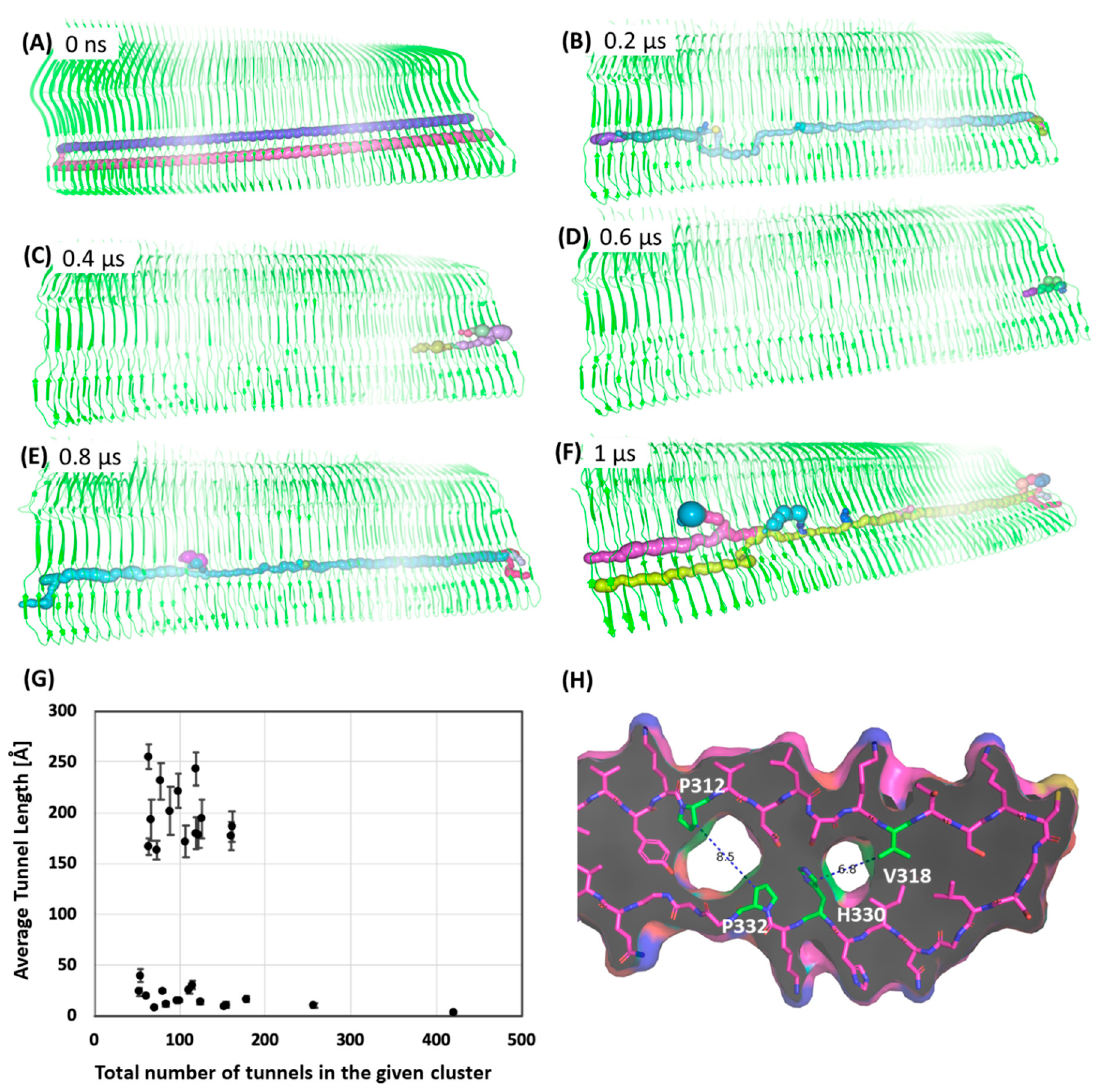
Figure 7. Tunnels predicted by the CAVER program in ( A ) cryo-EM structure and ( B – F ) structure taken from MD simulation. The snapshots taken after ( B ) 200 ns, ( C ) 400 ns, ( D ) 600 ns, ( E ) 800 ns, ( F ) 1 microsecond simulation showing tunnels around the cavity site. ( G ) Plot of the tunnel length and number of tunnels found by CAVER on 500 frames (extracted each at 2 ns from 1 microsecond MD simulation) of the unbound tau filament. ( H ) Surface of the Tau PiD structure showing cavities in the structure and distance between neighboring Pro residues.